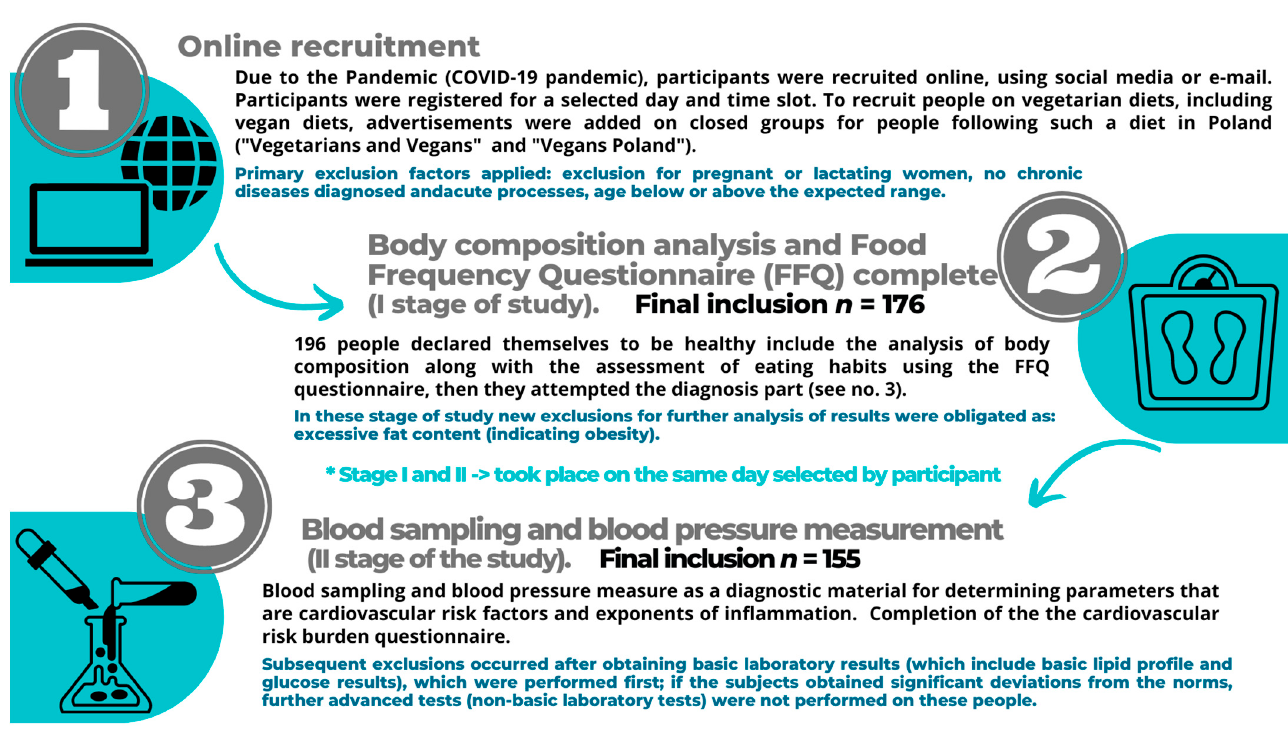
Figure 1. Scheme of the research